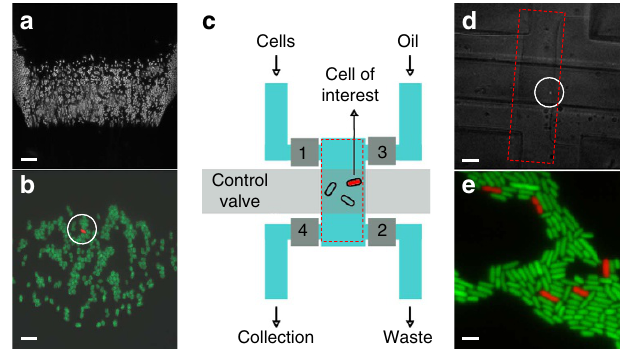
Figure 4 | MACS allows for rapid screening and recovery/enrichment of rare cells. ( a ) Single frame of a movie (Methods, Supplementary Movie 9) of GFP-expressing E. coli cells flowing during the half-open state. Cells appear somewhat blurred due to their constant movement within the